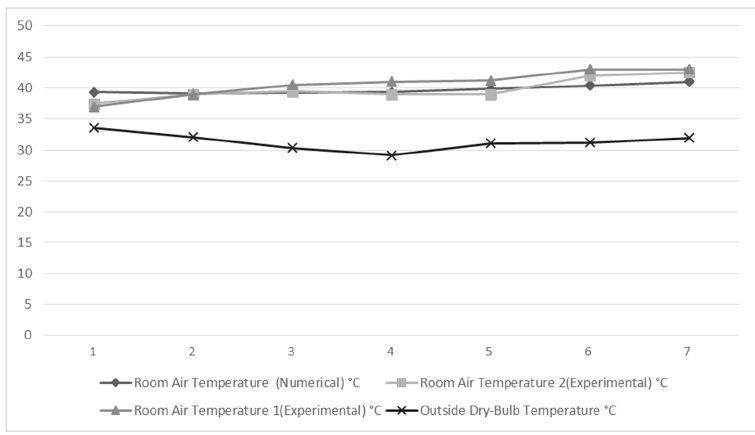
Figure 5. Comparison of mean daily temperatures from simulation and experimental study, with outside dry-bulb temperature.